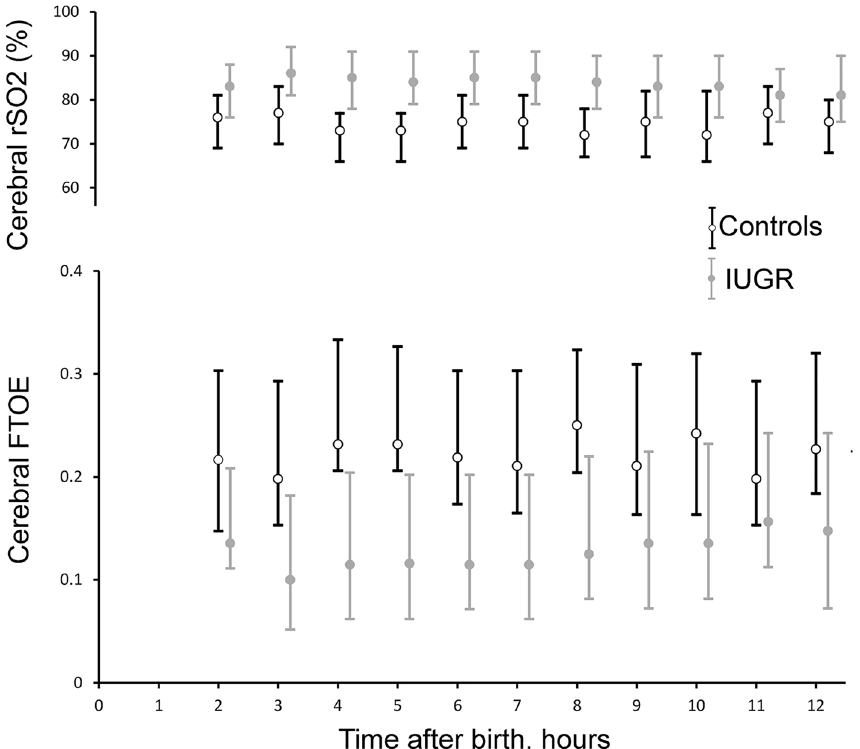
Figure 2. Cerebral regional oxygen saturation (rSO2) and fractional tissue oxygen extraction (FTOE) values recorded during the first 12 h after birth in intrauterine growth restriction (IUGR) (n = 105) and control (n = 105) newborns. Grey filled circles represent IUGR and black hollow circles control infants. Data are given as mean (circles) and standard deviation (error bar). There was a significant group difference, but the groups did not behave differently over